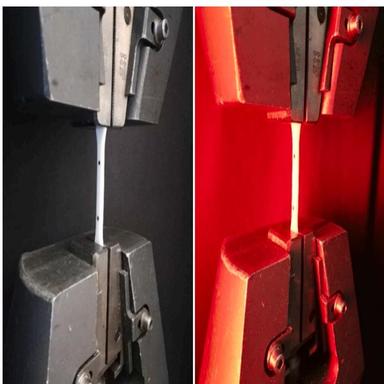
Tensile tests of SLS test specimens (type 1BA, ISO 527-2).